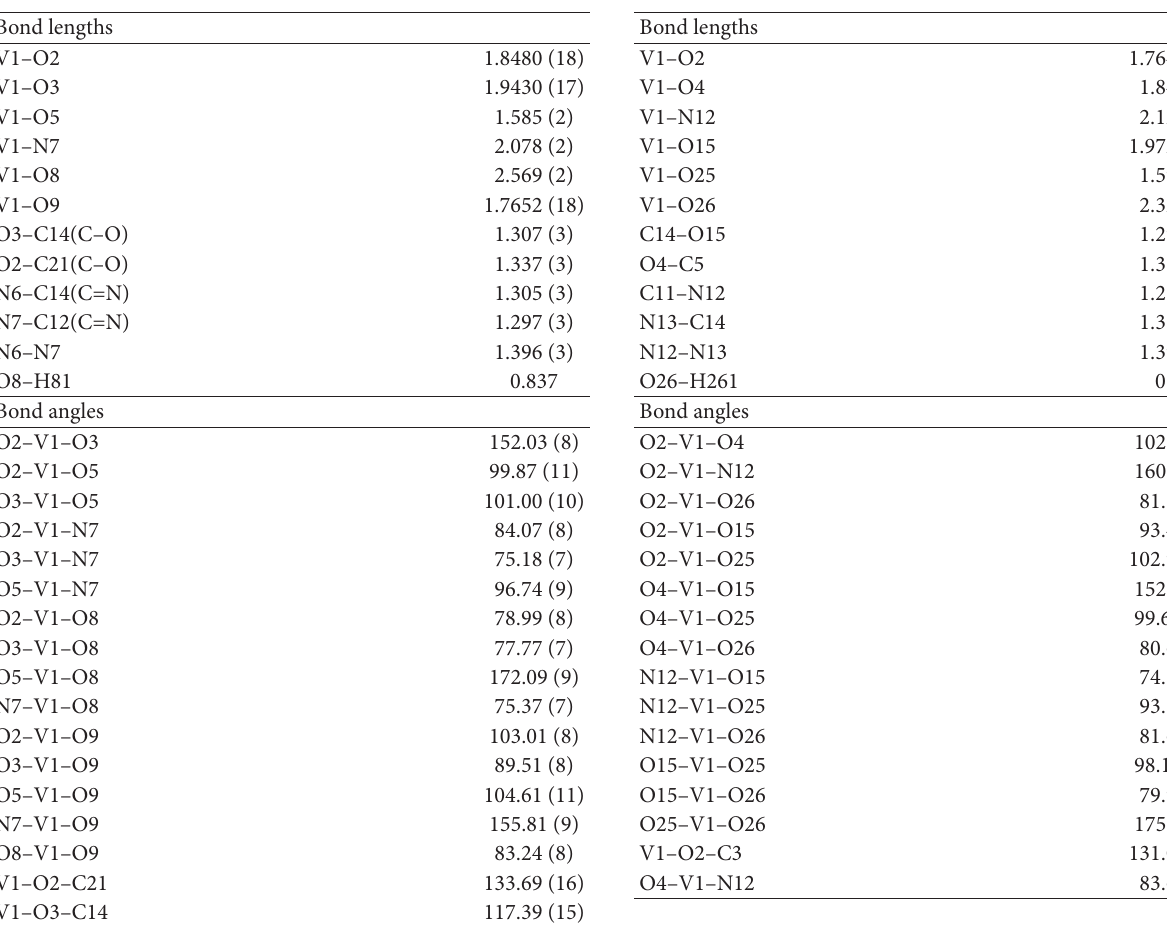
T 2: Selected bond lengths (Å) and angles (